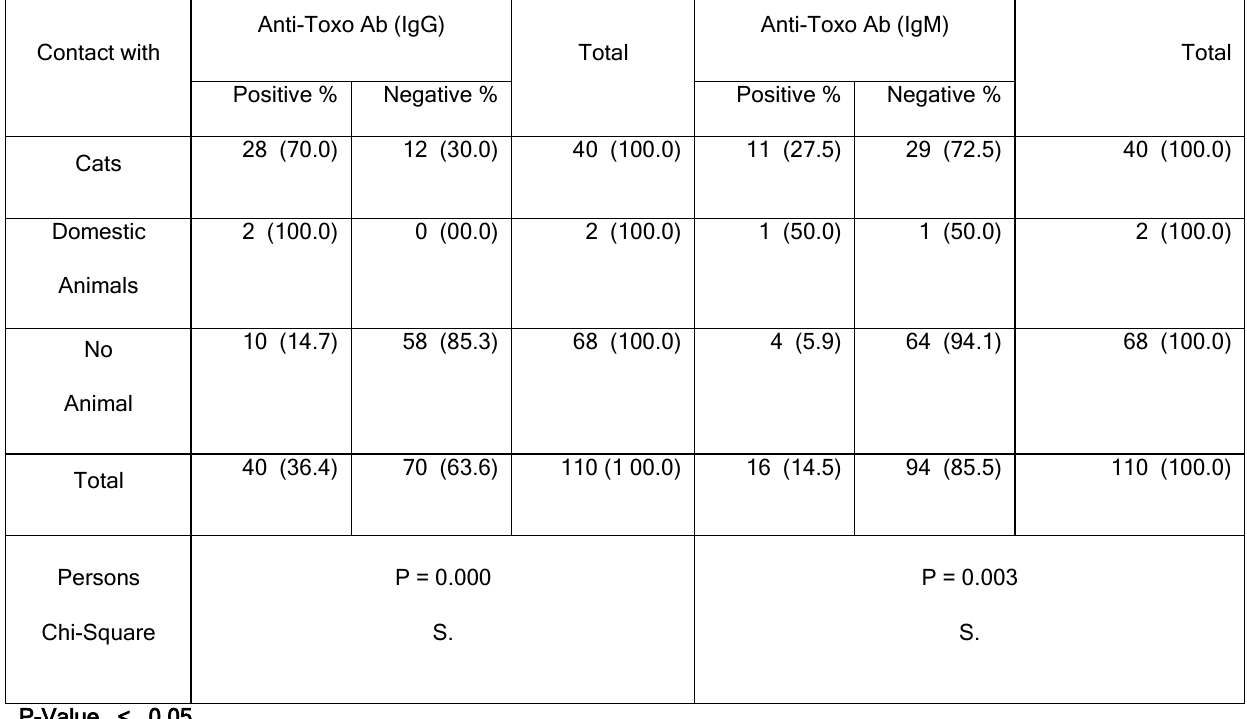
Table (6): Distrubution according to the seropositivity rates by ELISA (IgG, IgM) of Pregnant women contact with cats and domestic